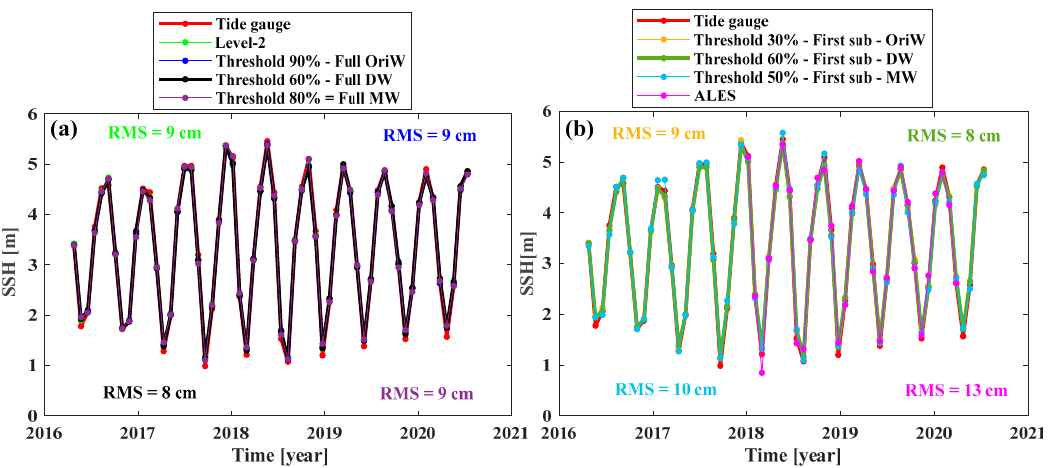
Figure 17. Water level time series of the Bay of Biscay pass 216 based on our waveform retracking scenarios and ALES dataset in front of tide gauges, ( a ): full-waveform and ( b ): sub-waveform.